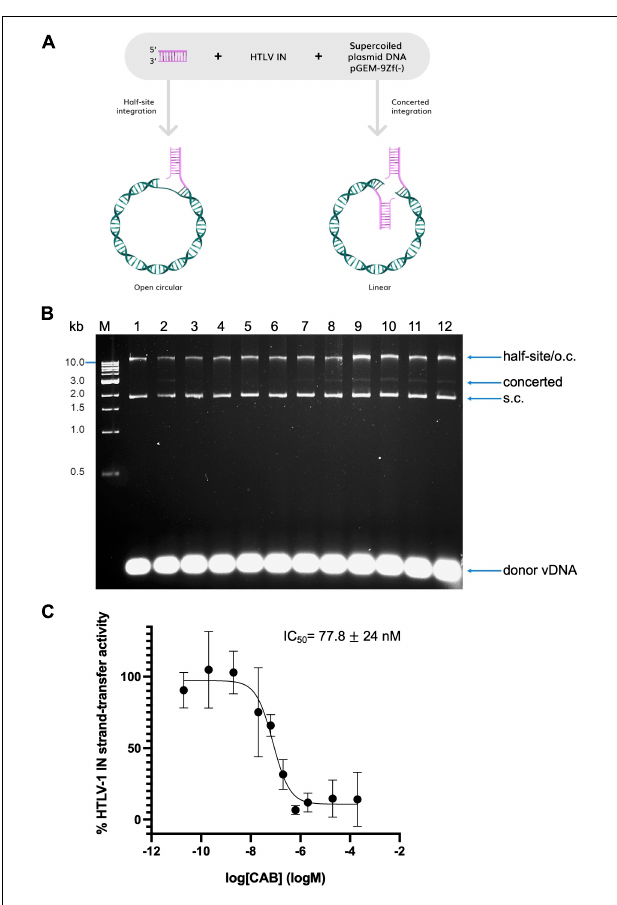
FIGURE 1 | Inhibition of in vitro strand transfer activity of recombinant HTLV-1 IN by CAB. (A) Schematic illustrating the strand-transfer assay. Products of half-site integration co-migrate with open circular forms of DNA; concerted integration linearizes the supercoiled target DNA. (B) Representative gel shown used to quantify IN inhibition by CAB as shown in panel (C) . Precipitated DNA samples were analysed on an agarose gel stained with ethidium bromide. Lane 1, negative control: no IN; lane 2: positive control, IN in the absence of drug. Lanes 3–12: in the presence of CAB; lane 3: 200 µ M, lane 4: 20 µ M, lane 5: 2 µ M, lane 6: 634 nM, lane 7: 200 nM, lane 8: 63.4 nM, lane 9: 20 nM, lane 10: 2 nM, lane 11: 200 pM, and lane 12: 20 pM. Migration of DNA species in the gel is indicated on the right of the gel. S.c., supercoiled; o.c., open circular. The 1 kb DNA ladder (NEB, indicated on the left of the gel) was used as a reference. (C) Dose-response curve of CAB calculated based on the amount of concerted integration activity of HTLV-1 IN quantified by densitometry. Averages and standard deviations of three independent replicates are shown.